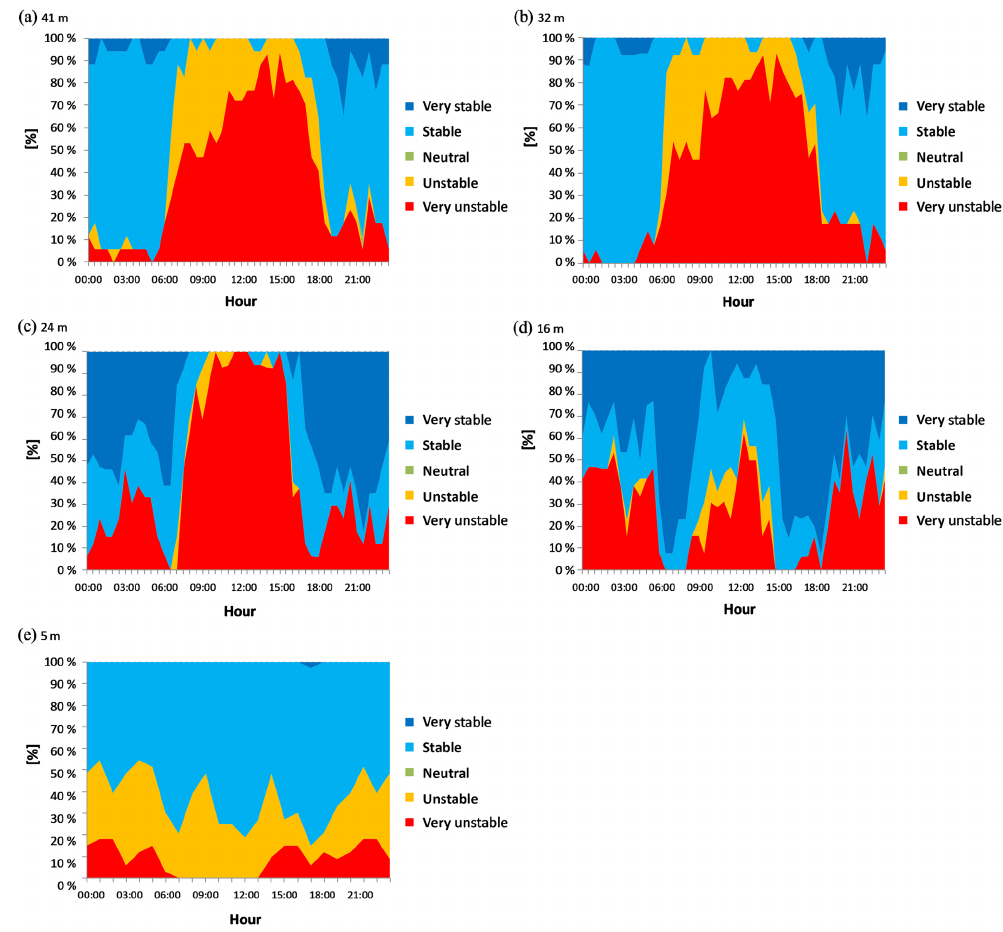
Figure 4. Stability class distributions in the different hours of the day expressed as function of z/L for the different levels: (a) 41m, (b) 32m, (c) 24m, (d) 16m and (e) 5m. z is the measuring height while L is the Obukhov length. The stability classes were classified as follows according to Gerosa et al. (2017): very stable: 0 < L ≤ 10; stable: 10 < L ≤ 100000; neutral: | L | > 100000; unstable: − 100000 ≤ L < − 100; very unstable: − 100 ≤ L <